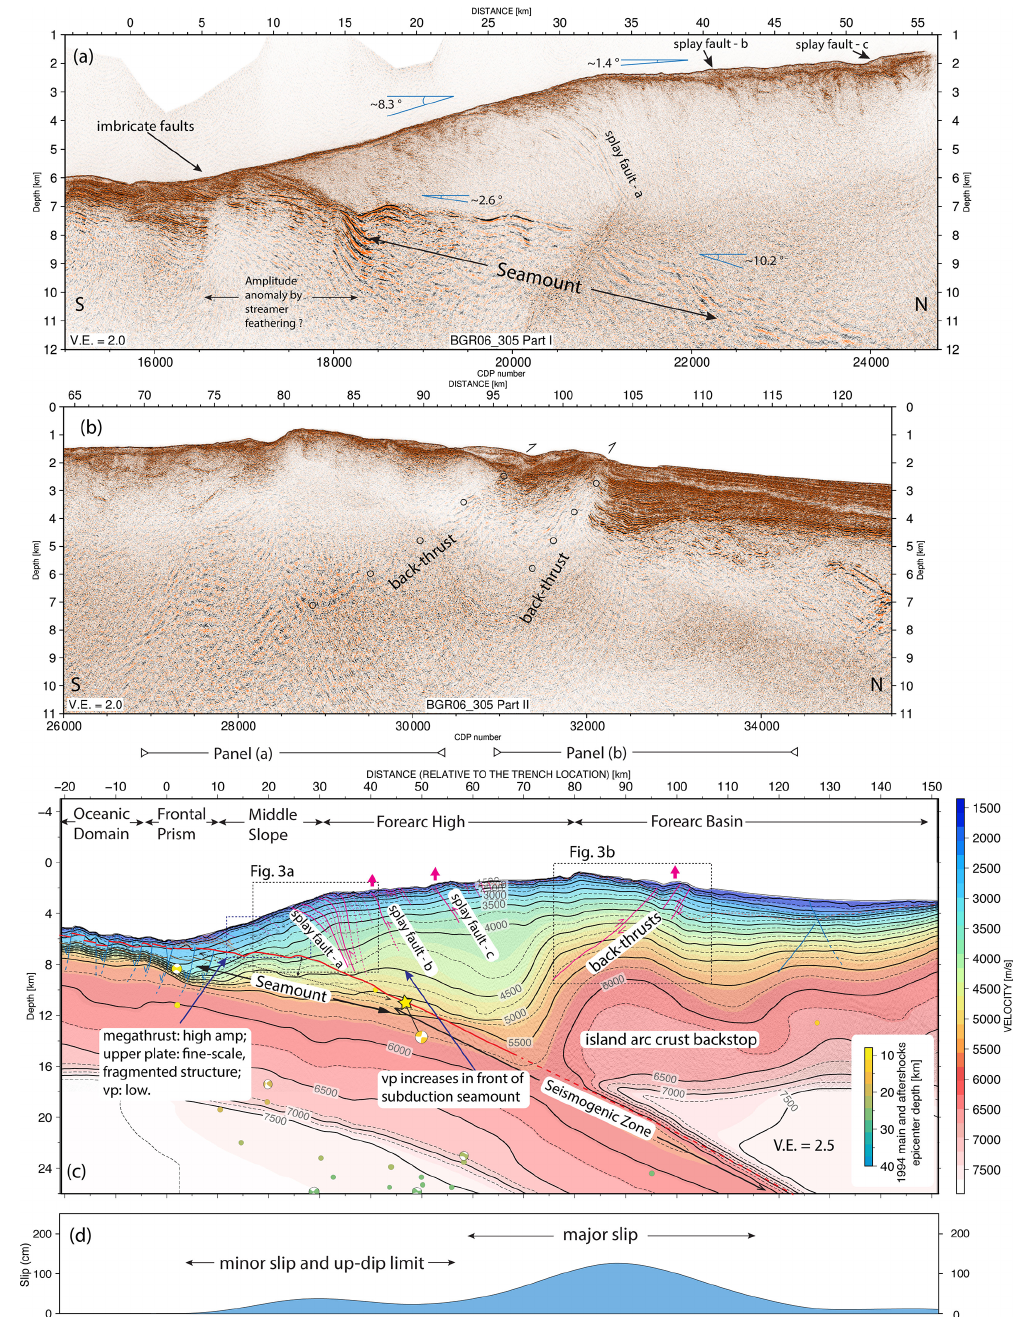
Figure 2. (a) Pre-stack depth-migrated section of seismic profile SO190 BGR06_305 from the trench to the forearc high domain. (b) Pre-stack depth-migrated section of seismic profile SO190 BGR06_305 covering the transition from the forearc high to the forearc basin. (c) Seismic section overlain by the vp model (based on MCS reflection tomography above 3km depth, velocities below from Shulgin et al., 2011; see Fig. S5), our structural interpretation, and the aftershock seismicity (from catalogue ISC-EHB Bulletin; Engdahl et al., 2020) of the 1994 Java tsunami earthquake. The hypocentre is marked as a yellow star. Coloured circles and beach balls are aftershocks (time span: 3 June 1994–14 October 1994) from the ISC-EHB Bulletin catalogue (Engdahl et al., 2020) and focal mechanisms from the gCMT catalogue (Dziewonski et al., 1981; Ekström et al., 2012). The well-developed forearc high (75–100km) results from back-thrusting above the island arc crust backstop. A subducting seamount between kilometres 5–45 is overlain by upper plate splay faults. (d) Co-seismic slip model of the 1994 earthquake along the profile (Bilek and Engdahl, 2007). Peak slip occurred underneath the backstop (55–105km) and decreased towards the subducting seamount